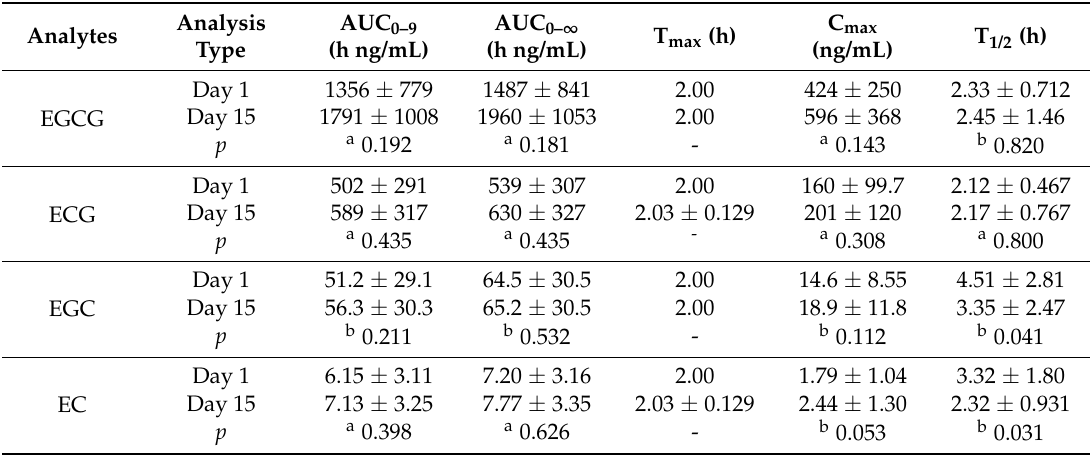
Table 5. Pharmacokinetic parameters of four catechins after oral administration of 630 mg green tea